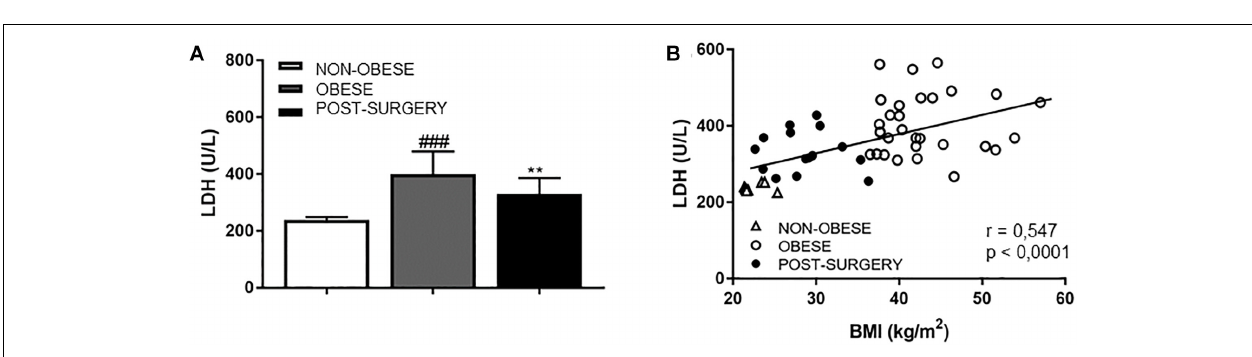
FIGURE 6 | (A) Diagram bars shows LDH concentrations in plasma samples from non-obese, obese and Post-surgery patients. Data are expressed as mean ± SEM of ≥ 7 determinations per group. ### p < 0.001 compared with the non-obese group. ∗∗ p < 0.01 compared with the obese group. (B) Correlation between LDH concentrations and BMI. White triangles correspond to non-obese, white circles correspond to obese and black circles correspond to